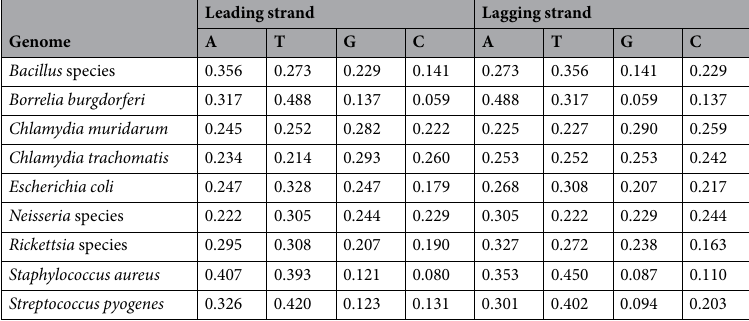
Table 4. Nucleotide stationary distribution generated by matrices from leading and lagging DNA strands for studied